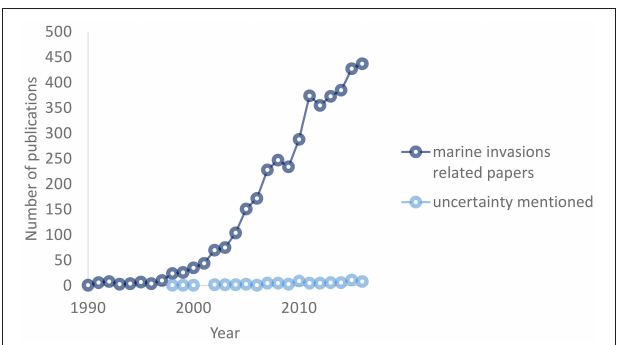
FIGURE 1 | Time series of publications registered in Scopus, including in the title or abstract or keywords at least one the words “biological invasions” or “non-indigenous species” or “alien species” or “invasive species,” and at least one of the words “marine” or “sea” (dark blue markers). If in addition one of the words “uncertainty” or “confidence” is included (light blue markers) the number of publications drops to 2% of the initial number